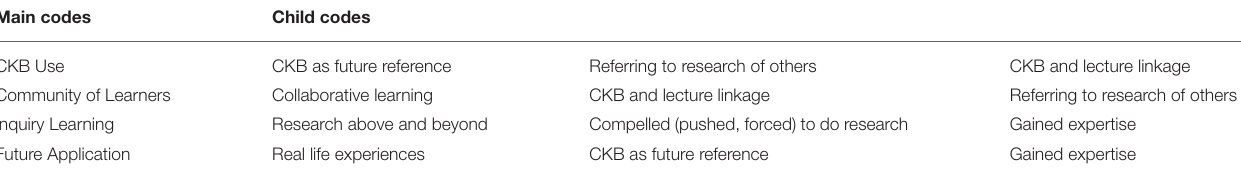
TABLE 1 | NVivo Main and Child Codes used to analyze test question and focus